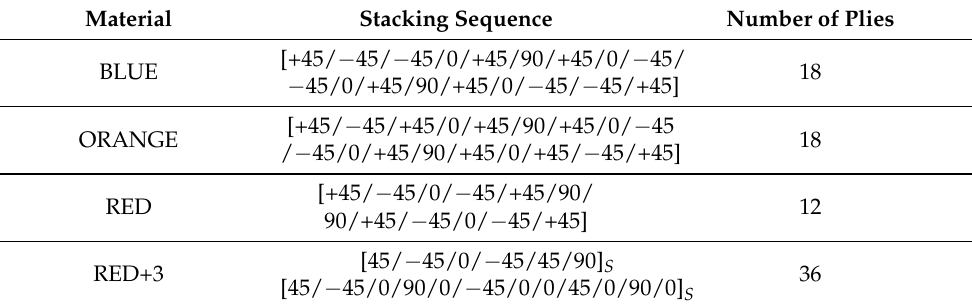
Table 1. MILANO UAV